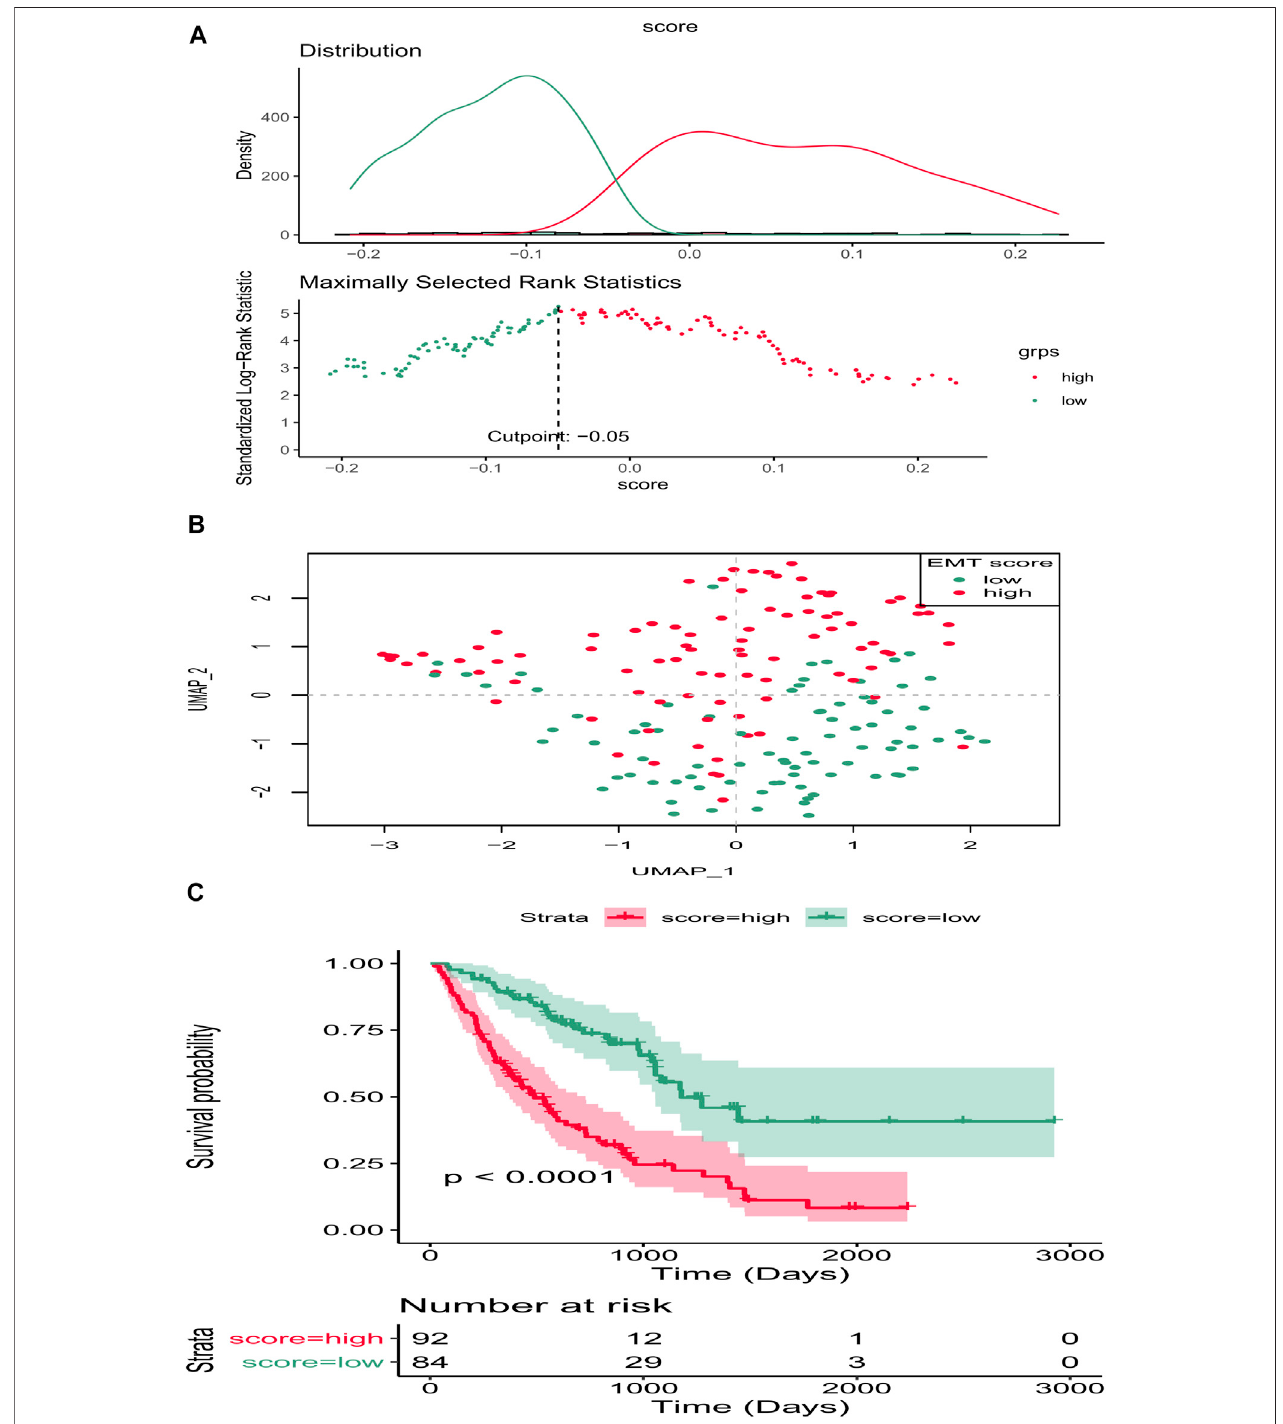
FIGURE 1 | EMT score affects the prognosis of IPF in the training set. (A) Optimal cutting point analysis suggested that the optimal cutting point of the EMT score was equal to − 0.05 in the training set. Green represents low score of EMT, and red represents high score of EMT. (B) UMAP cluster of IPF patients in the training set based on EMT-related genes. (C) Survival curve of high- and low-EMT score groups.